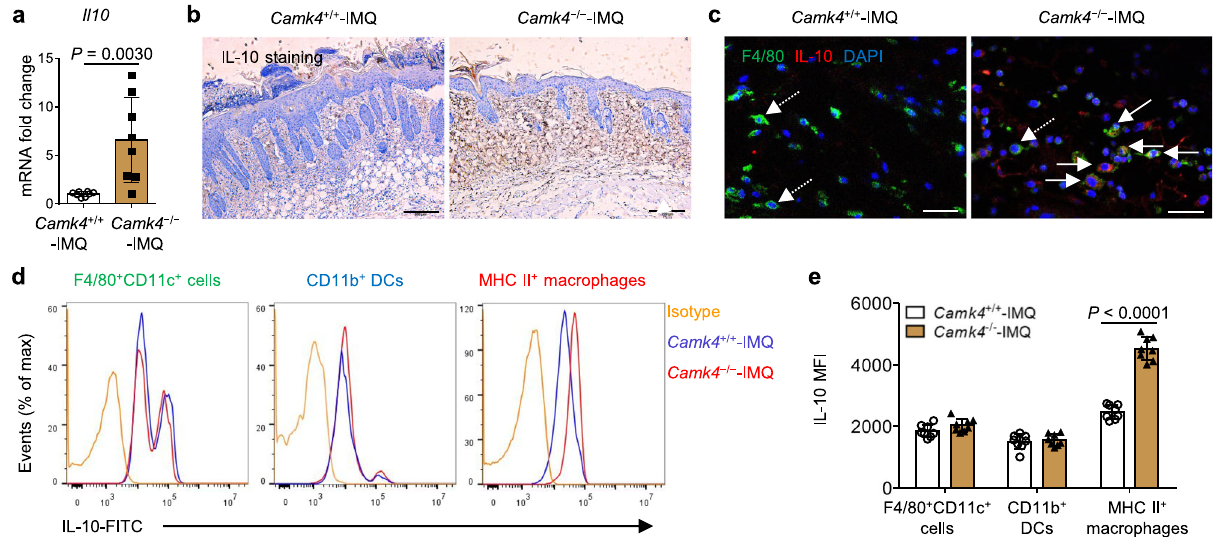
μ m. d The expression of IL-10 in F4/80 + CD11c + cells, CD11b + DCs, and MHC II + macrophages as determined by fl ow cytometry. e Statistical analysis of the MFI of IL-10. a – e N =8 per group from two independent experiments. Data are shown as mean±SD. For ( a ), two-sided Mann – Whitney test; for ( e ), two-sided unpaired Student ’ s t test. Source data are provided as a Source Data fi